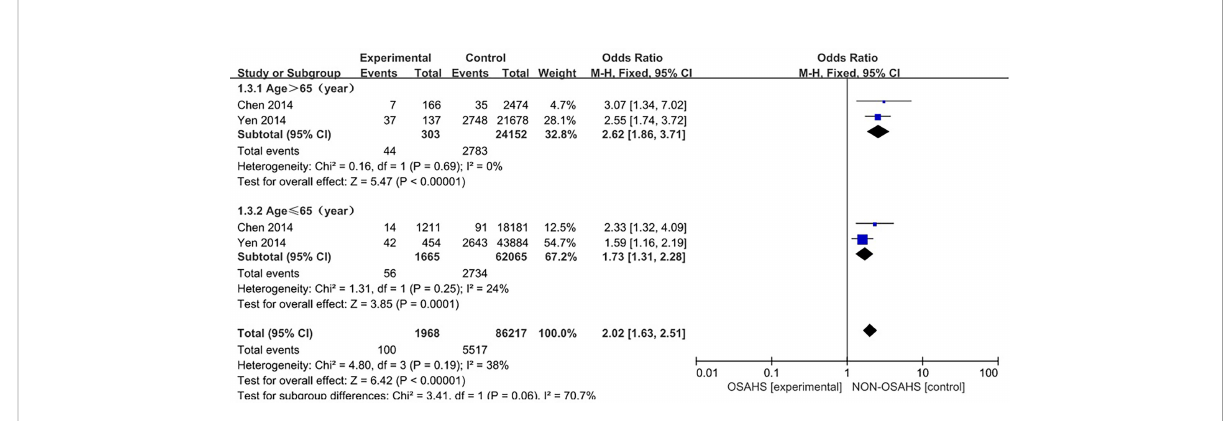
FIGURE 4 Forest plot of the incidence of osteoporosis in elderly (>65 years old) and middle-aged (40-65 years old)